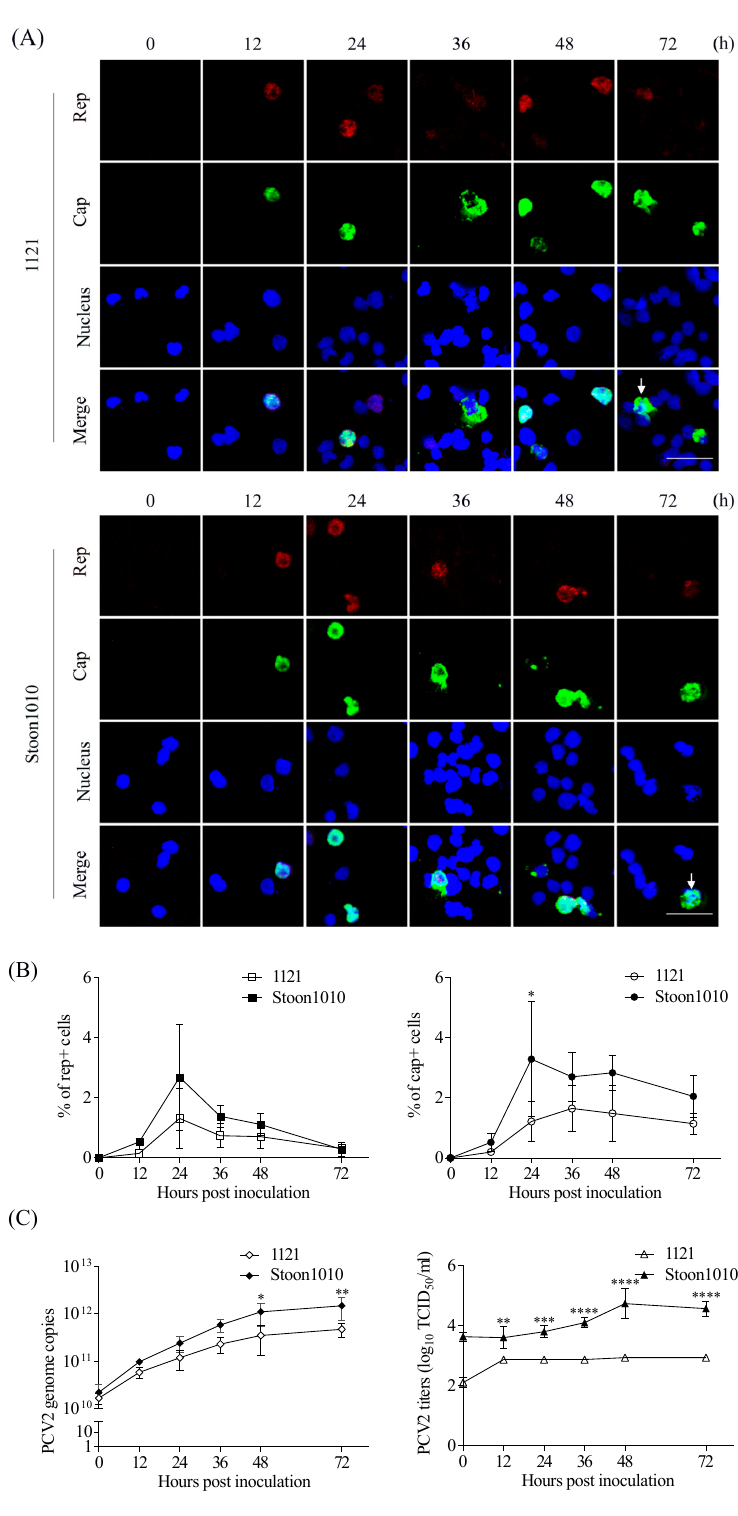
Figure 2. Porcine circovirus type 2 (PCV2) replication kinetics in T-lymphoblasts. Cells were inoculated with PCV2 strain 1121 or Stoon1010 at 0.05 TCID 50 / cell at 37 ◦ C for 1 h. Afterwards, the virus was removed and cells were cultured until the indicated timepoints. At each timepoint, cells were fixed and stained for the expression of PCV2 replicase (Rep) and capsid (Cap) proteins, while the culture supernatant was collected and examined for genome copies by qPCR and virus titration. ( A ) Confocal images showing the expression kinetics of Rep and Cap, with strain 1121 shown on top and strain Stoon1010 at the bottom. White arrows indicate irregularly shaped cells with intense PCV2 antigen expression and deformed nucleus. Scale bar= 50 µm. ( B ) The percentages of Rep+ cells and Cap+ cells were quantified for strain 1121 and Stoon1010, respectively. ( C ) Evolution of PCV2 genome copies and titers in the supernatant of T-lymphoblast cultures inoculated with strains 1121 or Stoon1010. Data represent mean ± SD of triplicate assays. * p < 0.05; ** p < 0.01; *** p < 0.001; **** p < 0.0001. 3.2. PCV2 Attachment to T-Lymphoblasts is Mediated by Chondroitin Sulfate 3.2.1. PCV2 Attachment is Restricted to 11–26% of T-Lymphoblasts Since virus binding is an initial step of the virus infectious cycle, we first examined PCV2 binding to T-lymphoblasts by incubating cells with PCV2 particles at 4 °C for 1 h. The bound virus particles were immunostained and visualized under confocal microscopy. Single and aggregate forms of PCV2 particles of strains 1121 and Stoon1010 bound to 11% and 26% of T-lymphoblasts, respectively (Figure 3A,B). In addition, the amount of attached particles per cell of Stoon1010 was twice that of 1121, as demonstrated by the fluorescence area measured with ImageJ (Figure 3C). These results revealed that PCV2 particles were able to bind certain proportions of T-lymphoblasts, with Stoon1010 being significantly more effective than 1121.